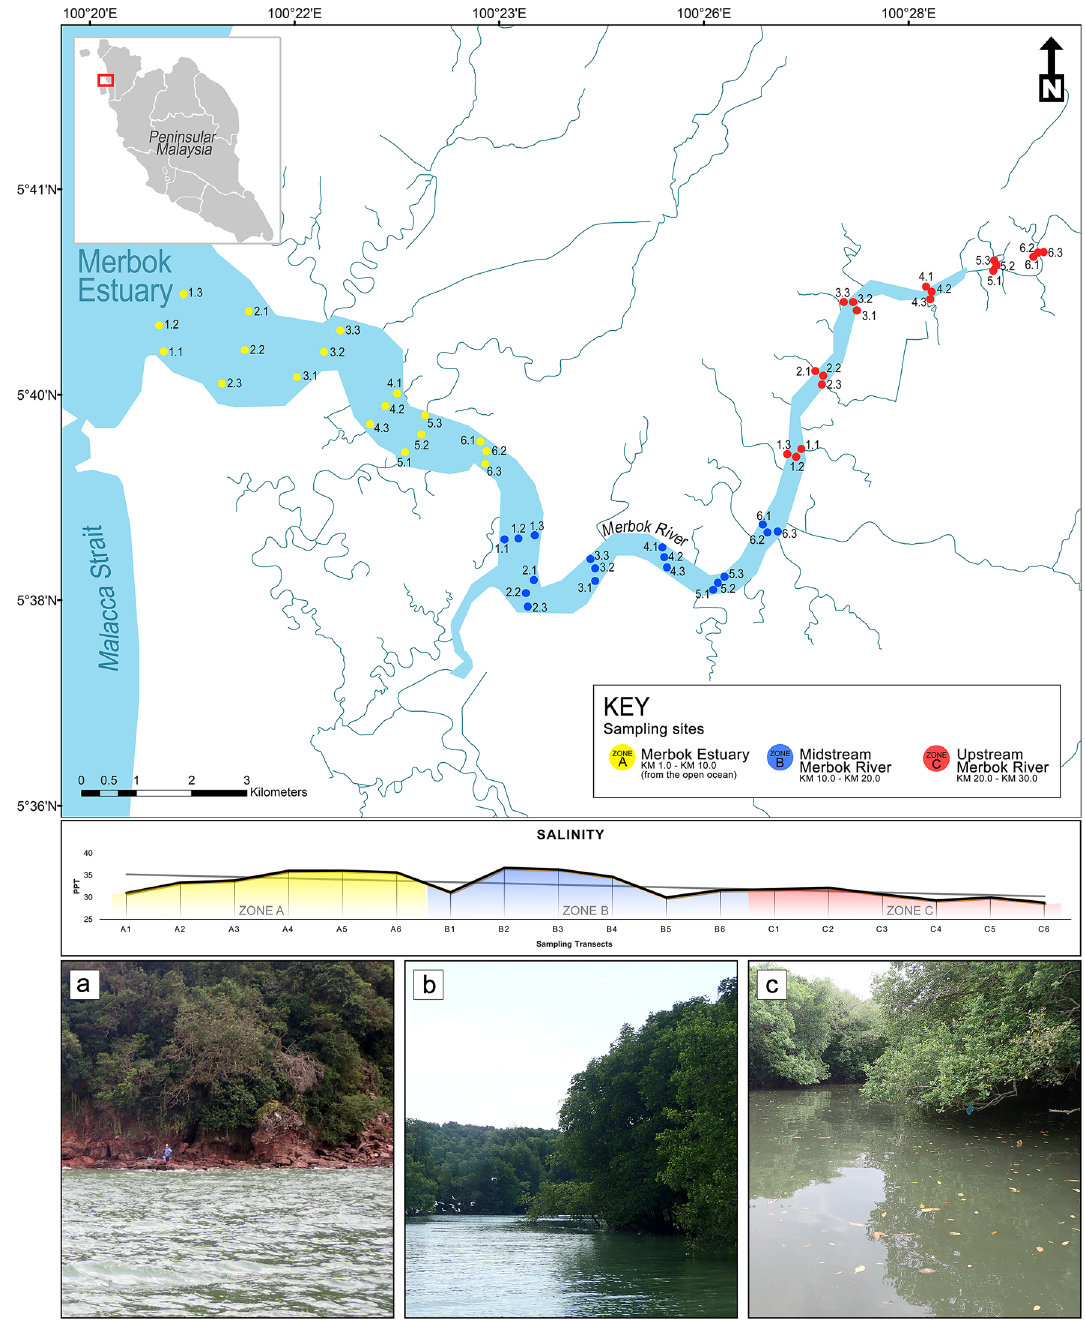
Figure 1. Location of sampling sites across the Merbok Estuary. Inset map shows the location of the study area within Peninsular Malaysia. The diagram shows the salinity measurements at the sampling sites, categorised by colour - shaded yellow: Zone A; blue: Zone B; and red: Zone C. Photographs of the representative sites within the three zones: ( a ) site A1.1, ( b ) site B3.2, ( c ) site C6.3. Map is generated using ArcMap 10.8 (http:// www. esri. com) and edited in Adobe Photoshop CC 2019 (https:// www. adobe. com/ produ cts/ photo shop.